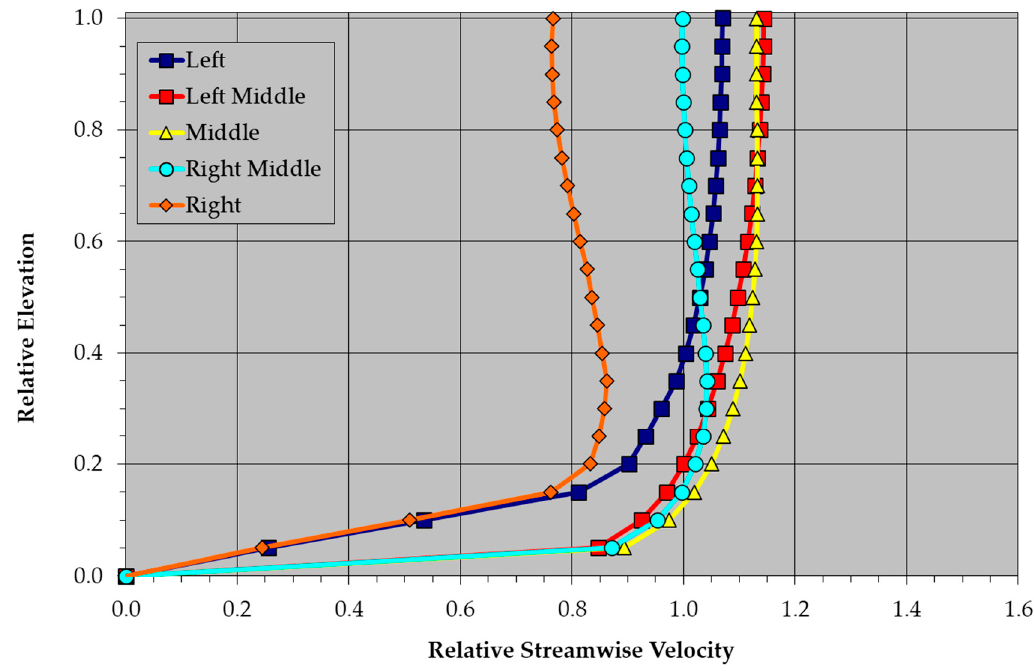
Figure 39. Vertical streamwise velocity profiles at Cross-section 810 (3rd meander bend) for Simulation Set 5 with a sinuosity of 2.75.